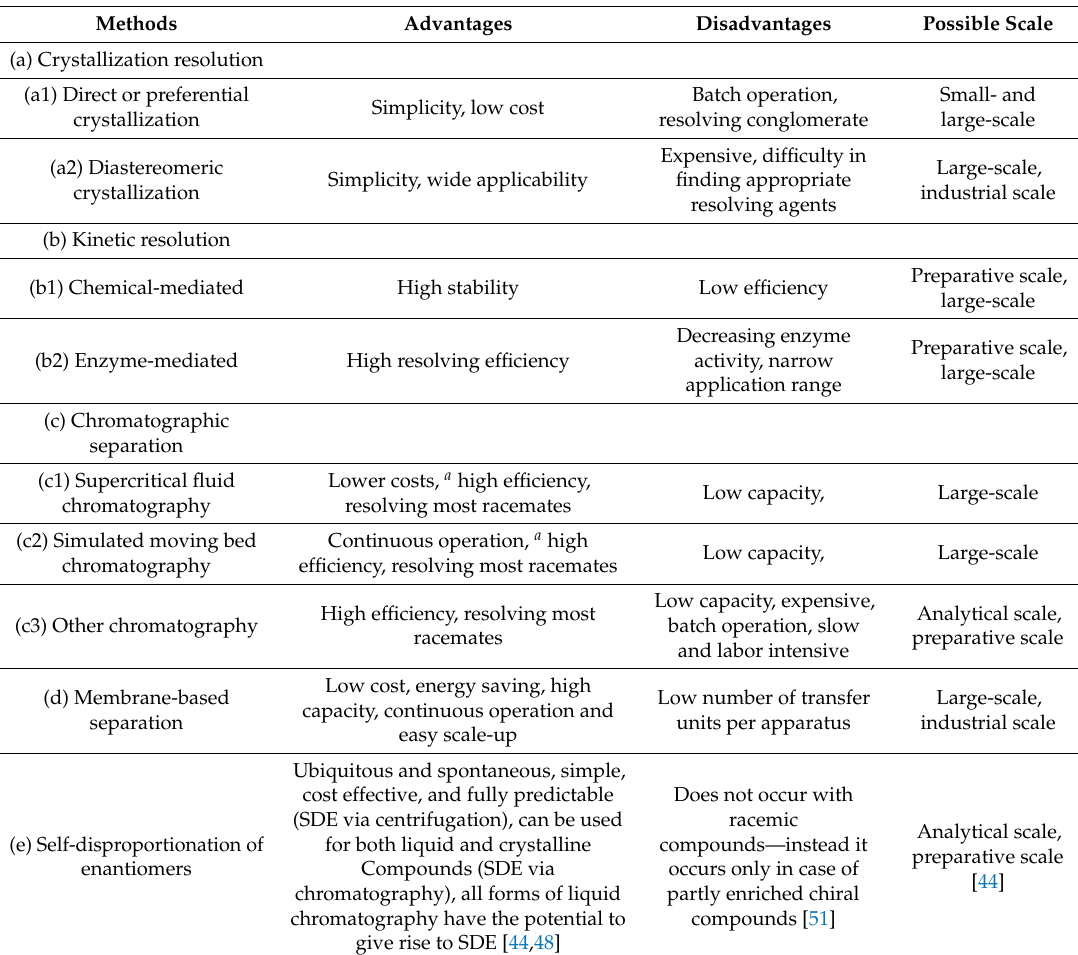
Table 1. Comparison of currently existing chiral resolution methods. The table and the caption have been adapted with permission from [50], Copyright © 2008 The Royal Society of Chemistry. Note that the original Table is slightly modified and the method “Self-disproportionation of enantiomers” has been